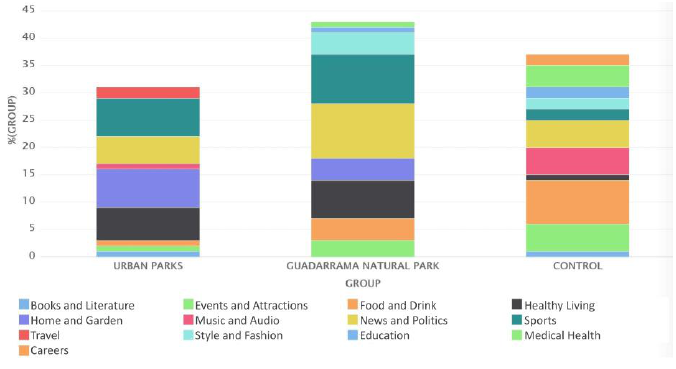
Figure 8. Comparison of topics among the three